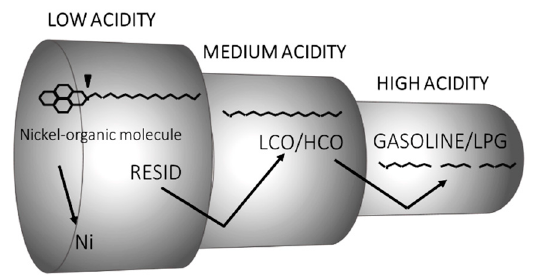
Figure 7. Pore hierarchy in an FCC catalyst.